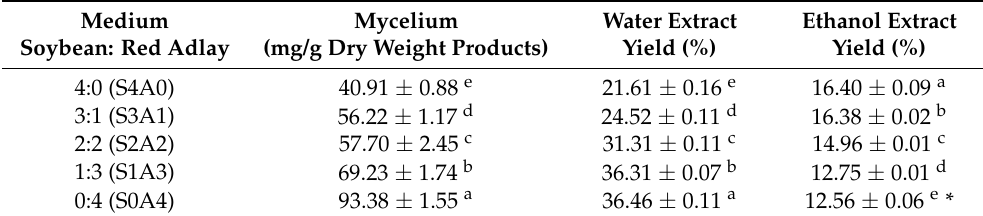
Table 1. Effects of different mixed media on mycelium contents and yields of water and ethanol extracts of mycelial products of white truffle solid-state fermentation.